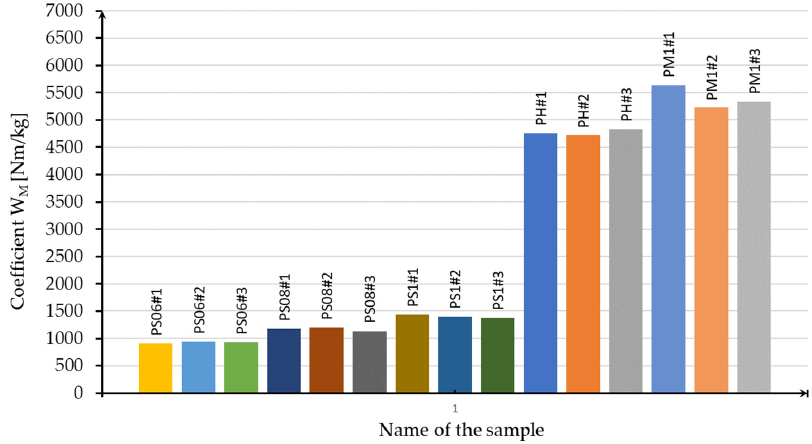
Figure 18. Columnar diagram with the values of the moment-to-torsion angle ratio for all tested samples.